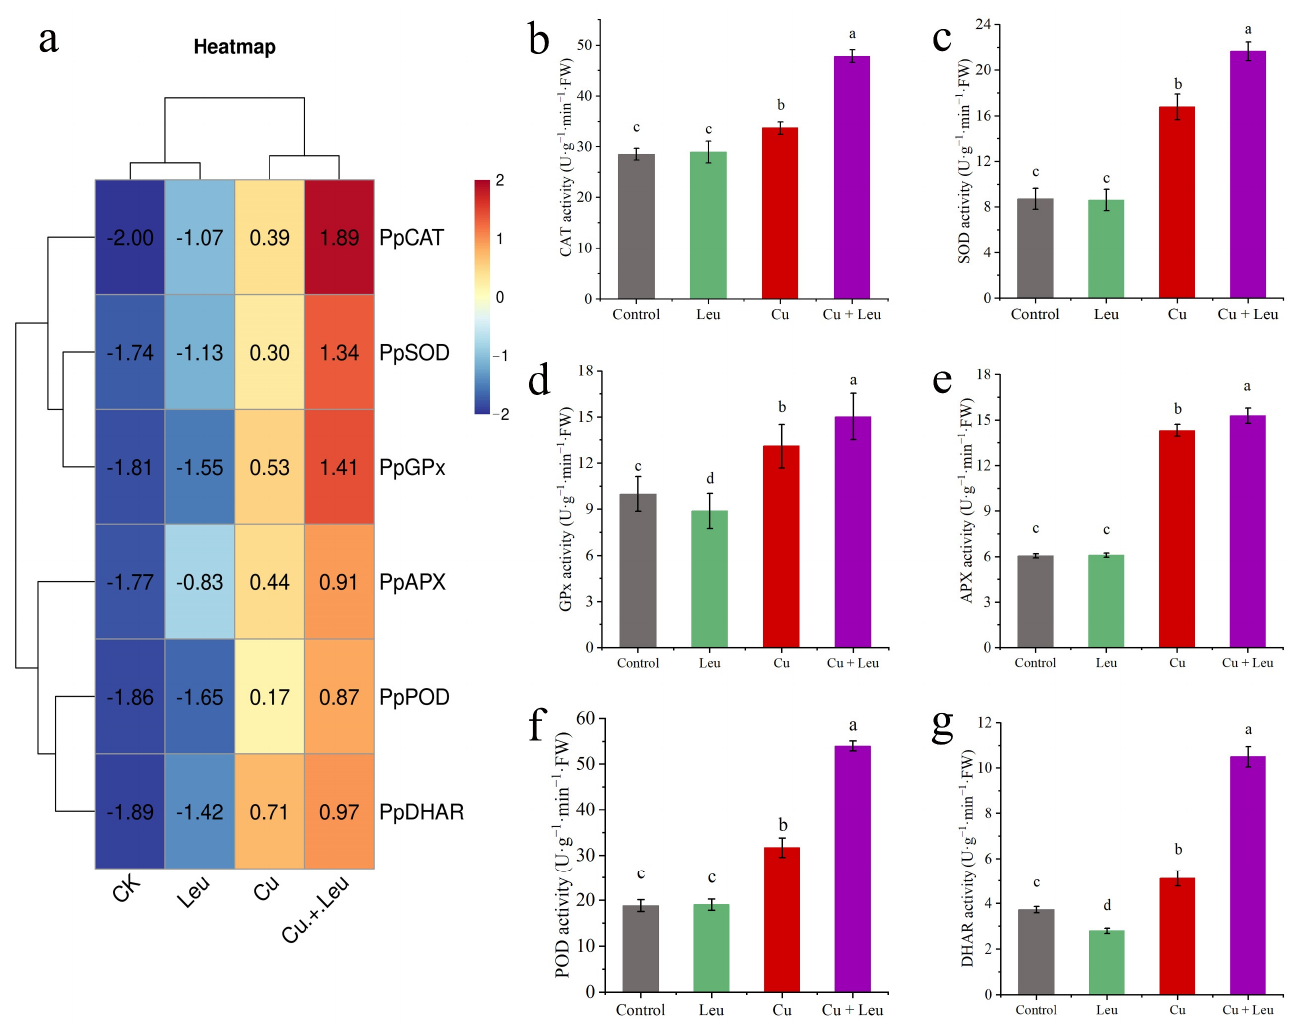
Figure 3 . Effects of different treatments on antioxidant protective enzyme gene expression and enzyme activities in peach seedlings. ( a ) The expression of antioxidant enzyme genes; ( b ) CAT activity; ( c ) SOD activity; ( d ) GPx activity; ( e ) APX activity; ( f ) POD activity, ( g ) DHAR activity). Error bars represent standard deviations of the means ( n = 3). Different lowercase letters indicate significant differences among different treatments (Duncan test, p < 0.05).